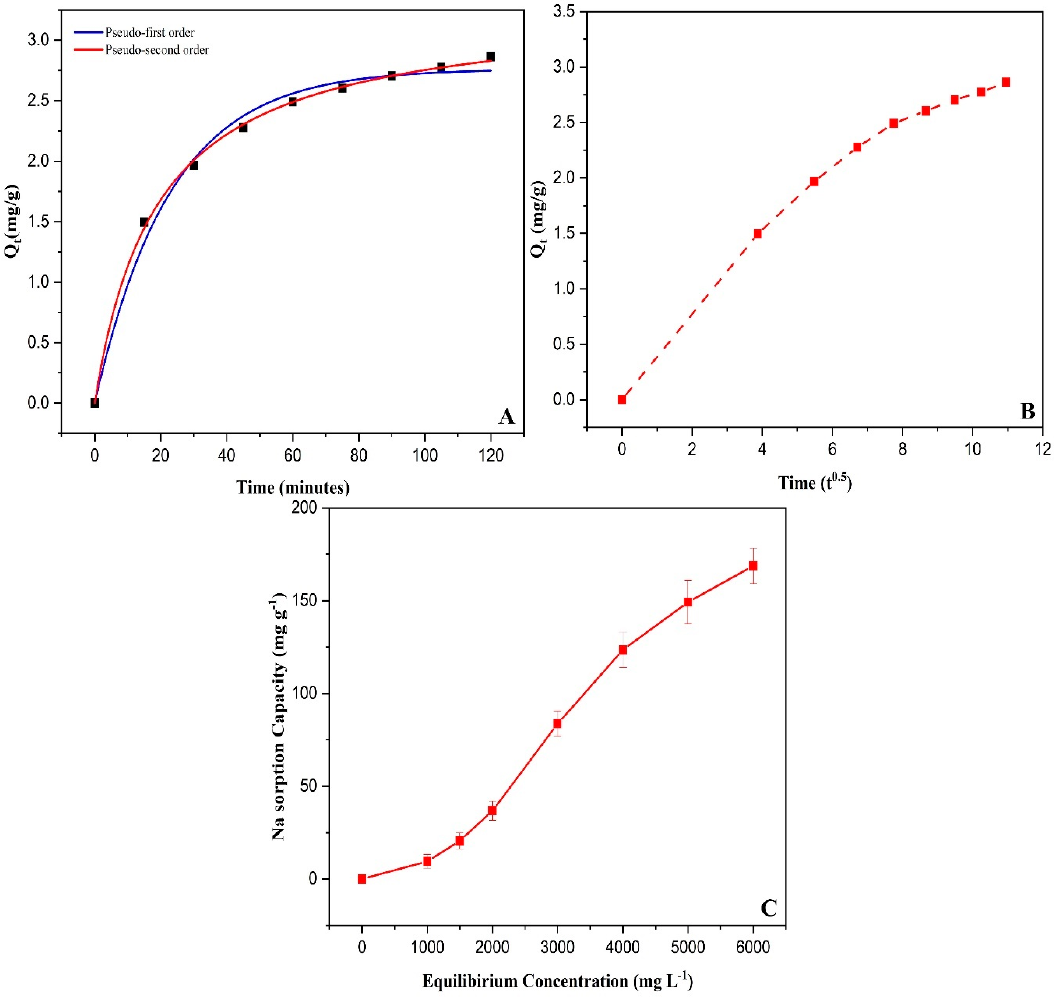
Figure 1. Sorption kinetics of Na + on chitosan modified biochar using ( A , B ); sorption isotherm of Na + on chitosan modified biochar ( C